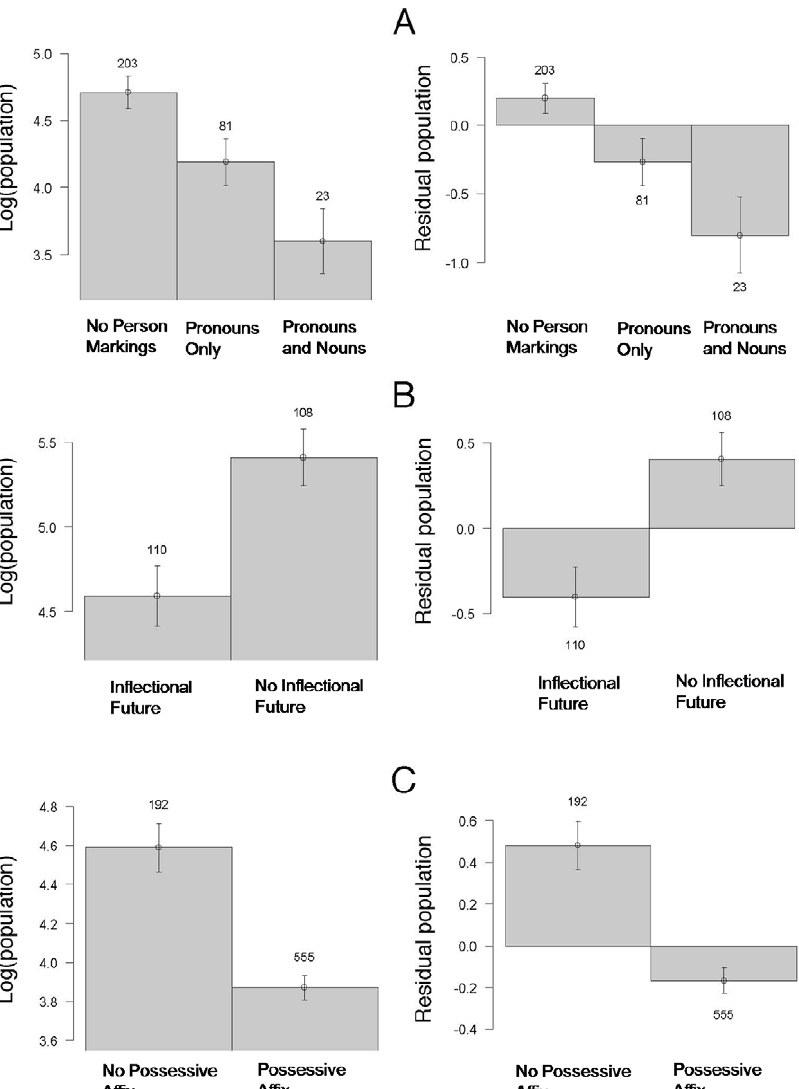
Figure 2. Three features demonstrating the relationship between population and morphological encoding. Y-axis of right-side panels displays residual population after the GLM model partialed out geographic information (reducing the correlation between population and geography to 0). Values above bars represent the number of languages coded for that feature value. (A) Adpositions (prepositions or postpositions) may be coded for person agreement in some languages. In English, there is no such agreement/person marking. One may say ‘‘from him’’ without, for example, encoding onto ‘‘from’’ the gender or number identity of ‘‘him,’’ as opposed to ‘‘me’’ in ‘‘from me.’’ Languages that do encode more information on adpositions show smaller populations. (B) Languages that use inflections (i.e., morphology) for the future tense have smaller populations. (C) Morphological encoding of possession is associated with smaller populations of speakers.